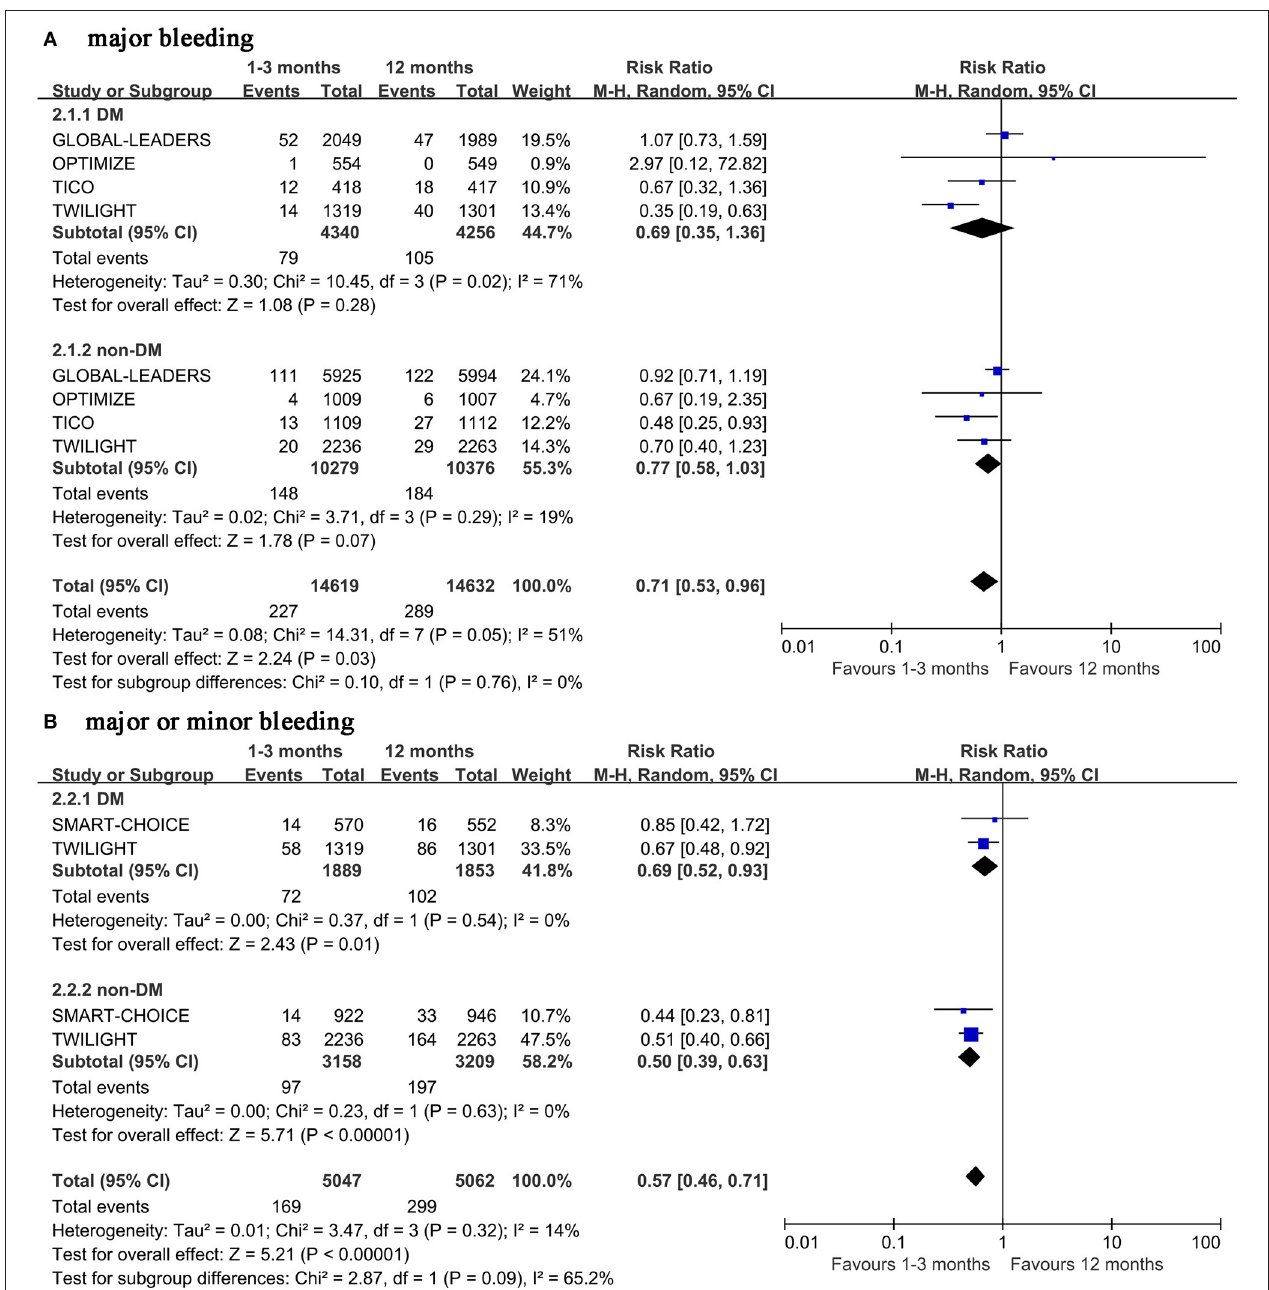
FIGURE 3 | Forest plot of bleeding outcomes in patients with or without diabetes mellitus according to duration of